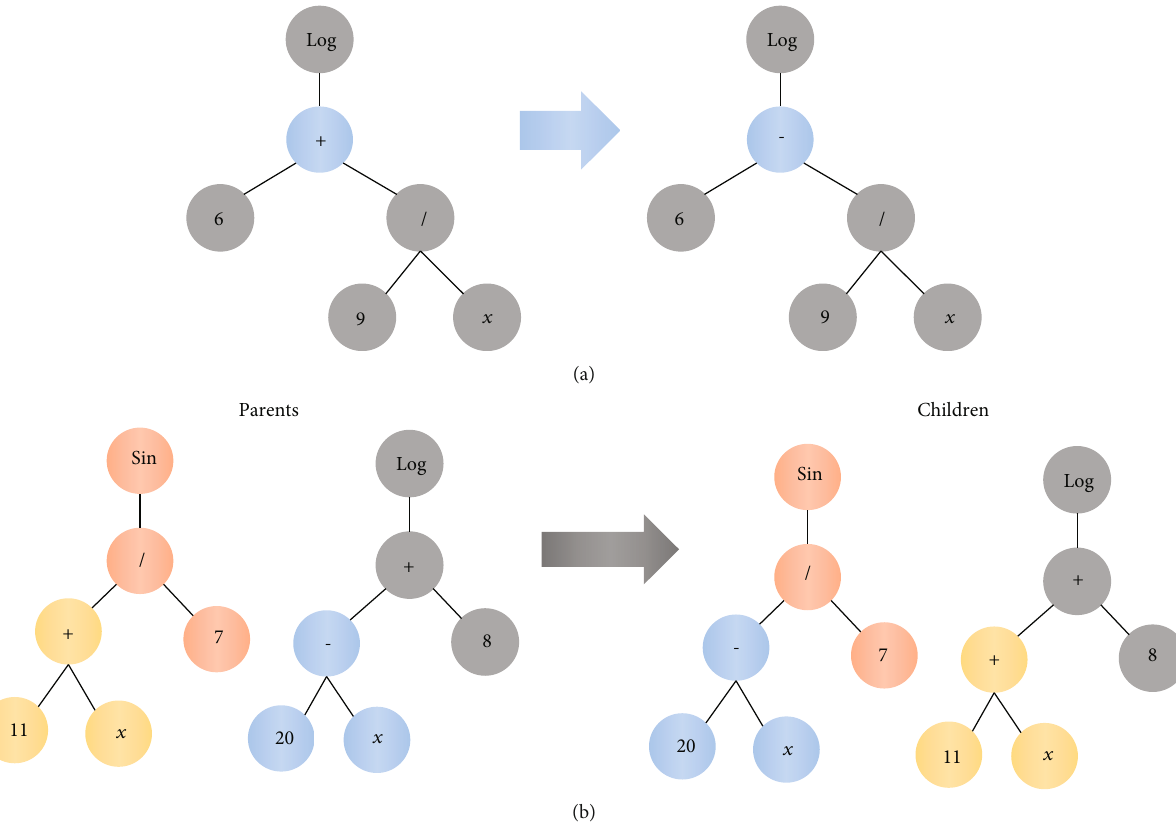
Figure 3: Genetic operators: (a) mutation operation; (b) crossover operation.